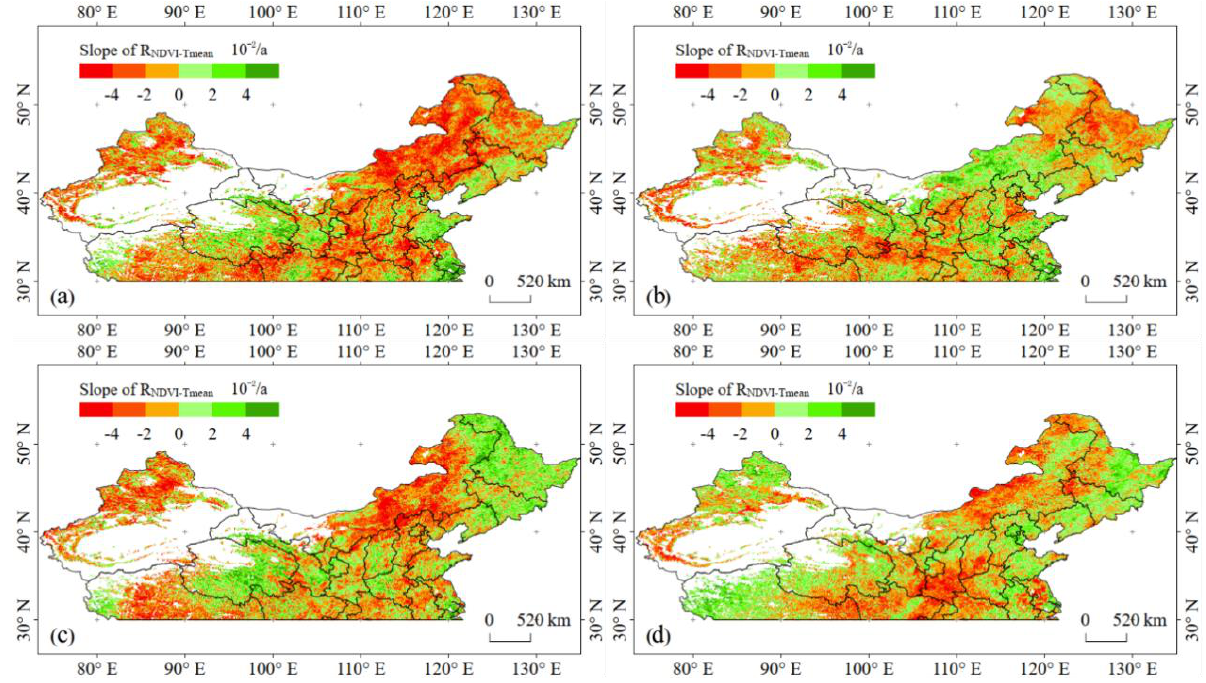
Figure 3. Spatial distribution of the trend of partial correlation coefficient between NDVI and daily mean temperature (R NDVI−Tmean ) during 1982–2015 for growing season ( a ), spring ( b ), summer ( c ) and autumn ( d ).